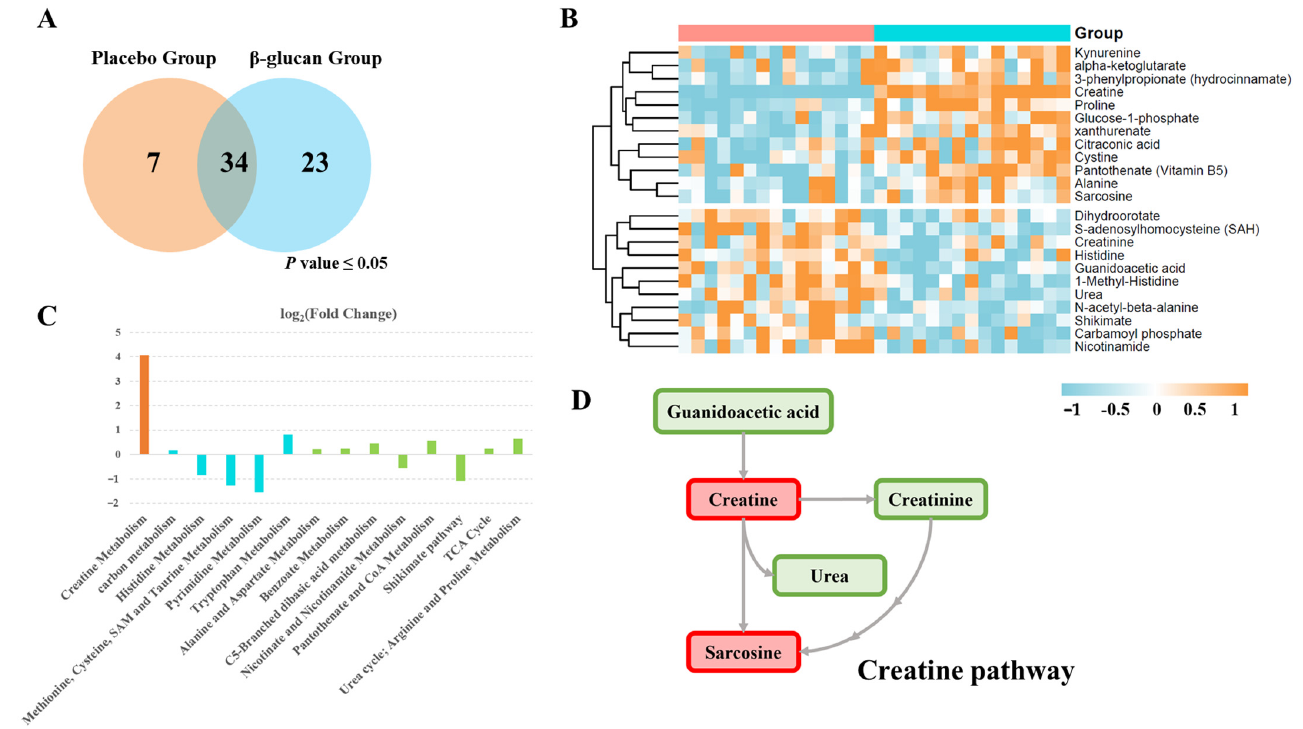
Figure 3. β -glucan supplementation activates the creatine signaling pathway in plasma. ( A ) Venn diagrams resuming the number of plasma metabolites significantly changed ( p < 0.05) in the placebo group and β -glucan group. ( B ) The heatmap showing changes in the relative content of plasma metabolites after β -glucan treatment. (Wilcoxon rank sum tests;). ( C ) Major metabolic pathways involved in the differentially enriched metabolites after β -glucan treatment (count indicates metabo- lites enrolled in each pathway). ( D ) Reaction steps for creatine pathway. Metabolites increased after β -glucan treatment are shown in red, whereas the metabolites decreased are shown in green.